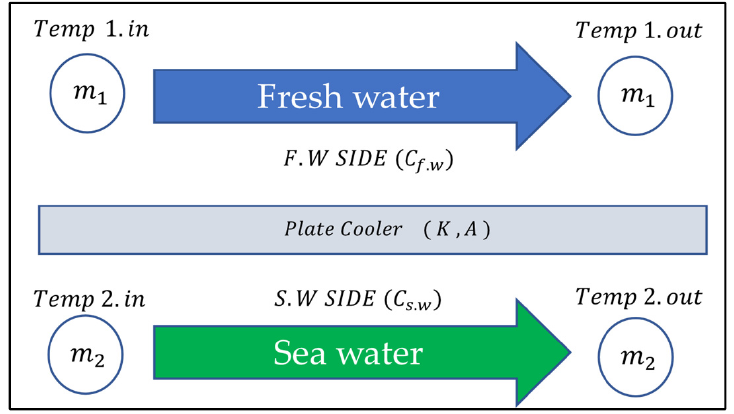
Figure 7. Heat flow of plate type cooler.